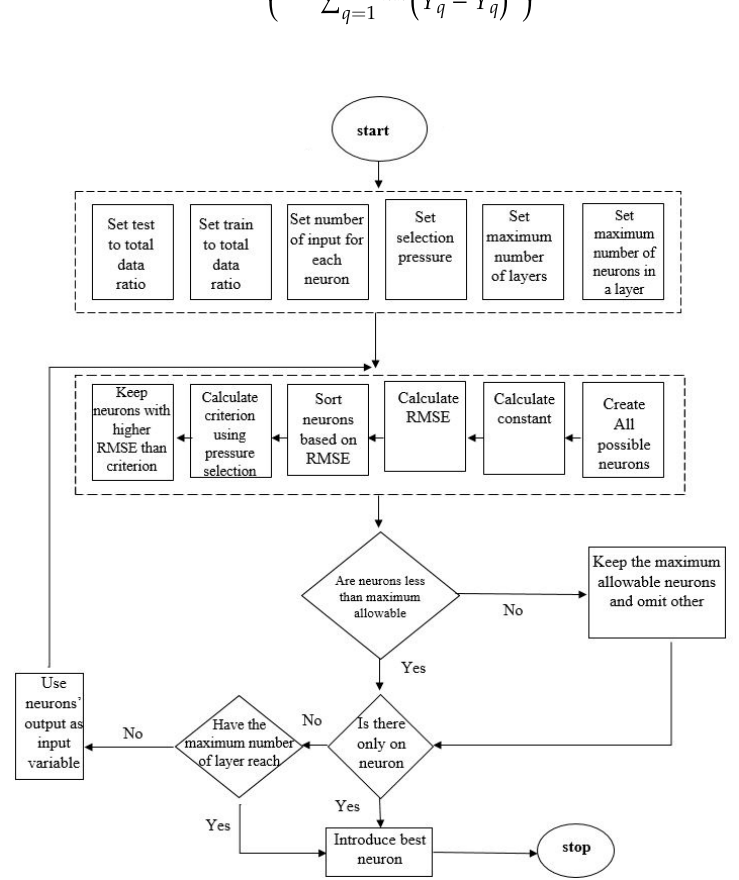
Figure 3. The general trend of implementing a GMDH model.